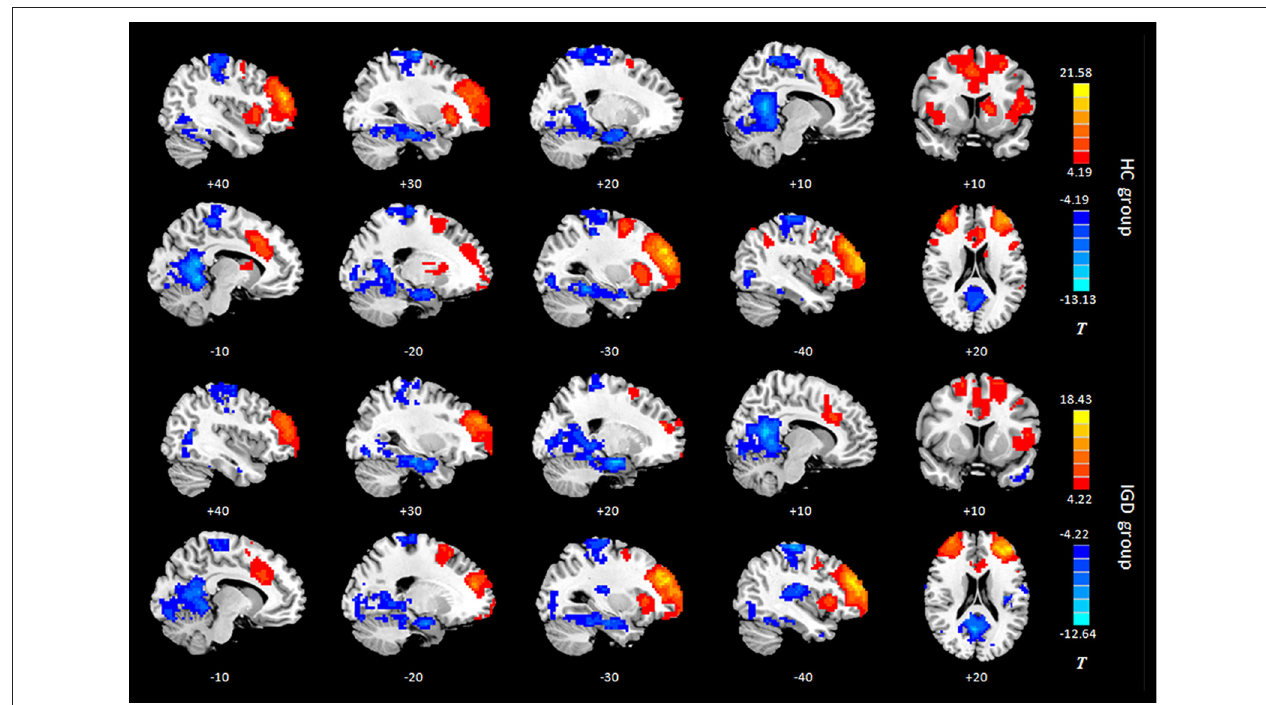
FIGURE 1 | Intragroup maps of connectivity to the left DLPFC of the resting-state networks. Significant connectivity regions are overlaid on the MNI template ( p < 0.001, FDR-corrected). Color bar, yellow (orange): positive functional connectivity (FC), blue: negative FC. HC, healthy control; IGD, internet gaming disorder; DLPFC, dorsolateral prefrontal cortex; MNI, Montreal Neurological